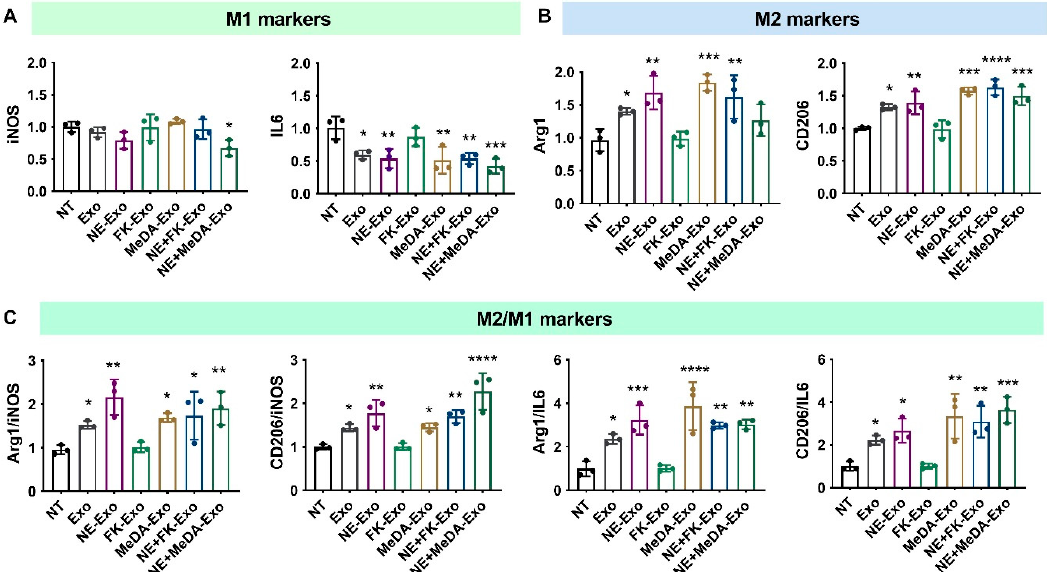
Figure 3. Polarization of macrophages with compound-treated MSC-derived exosomes. ( A ) Inflammatory macrophage (M1) markers iNOS and IL6 . ( B ) Anti-inflammatory macrophage (M2) markers Arg1 and CD206 . ( C ) M2/M1 ratios. One-way ANOVA with Dunnett’s multiple comparisons test, * p < 0.05, ** p < 0.01, *** p < 0.001, **** p < 0.0001; n = 3.